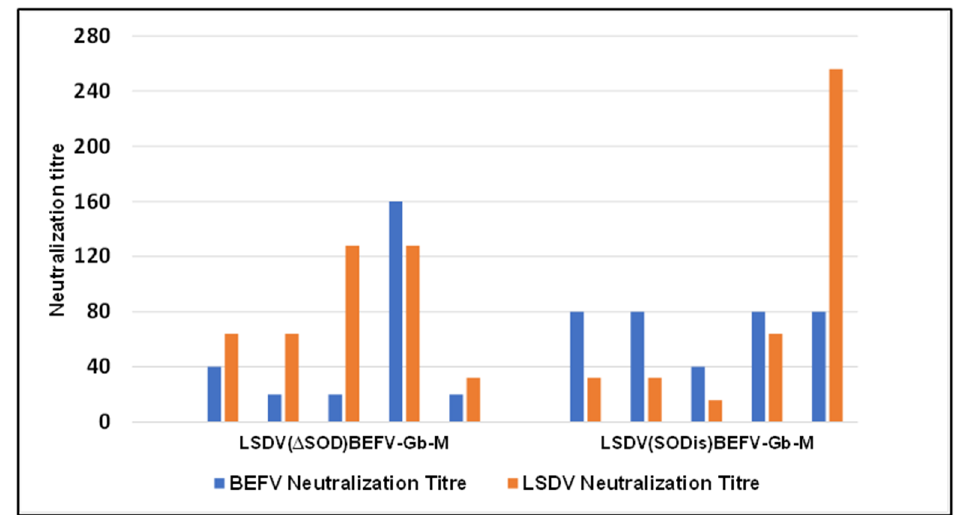
Figure 6. Comparison of two different LSDV vector backbones with the same BEFV gene inserts. Rabbits ( n = 5 per group) were given three inoculations, 28 days apart, of either LSDV( ∆ SOD)BEFV-Gb-M or LSDV(SODis)BEFV-Gb-M, intramuscularly, at a dose of 10 6 ffu per rabbit. Blood was taken 14 days after the final inoculation and serum was tested for neutralization of BEFV and LSDV. Neutralization titres are expressed as the reciprocal of the dilution required to neutralize virus in 50% or more of wells of cells infected with BEFV (blue) or LSDV (orange), respectively.